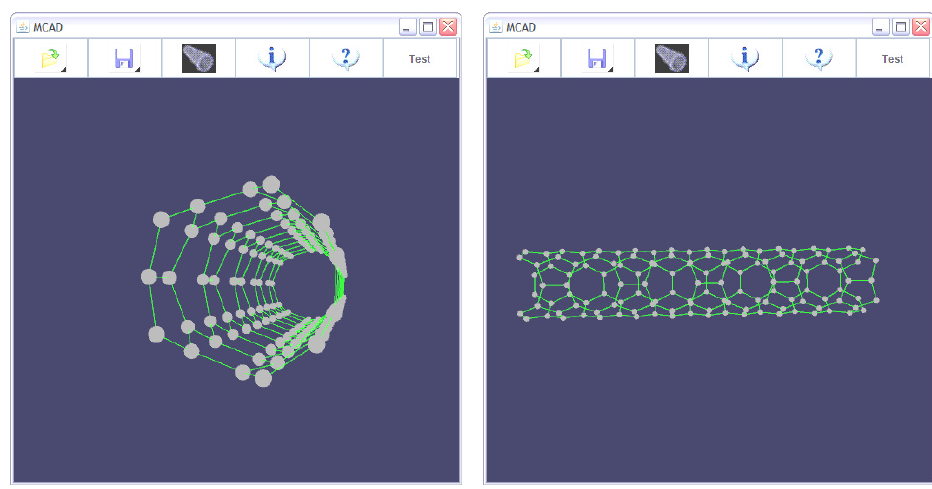
Figure 7. A zipper NT representation generated by